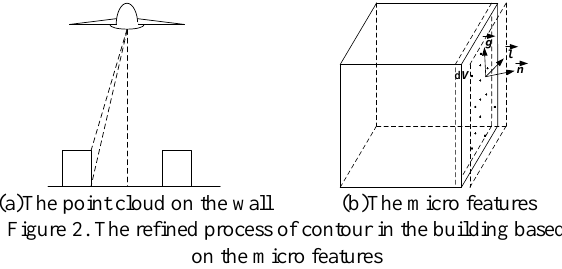
Figure 2. The refined process of contour in the building based on the micro features